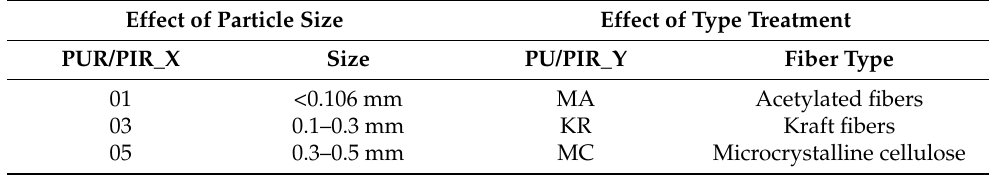
Table 3. Nomenclature for RPUF and PIR reinforced